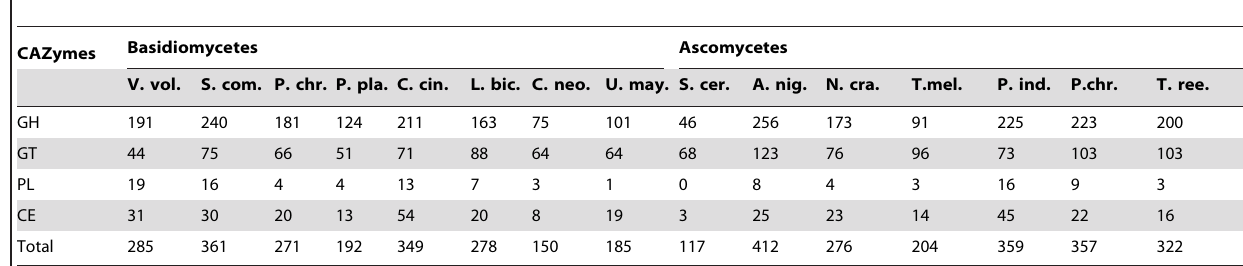
Table 1. Comparison of the number of CAZymes in V. volvacea genome with those in other fungi genomes [3].